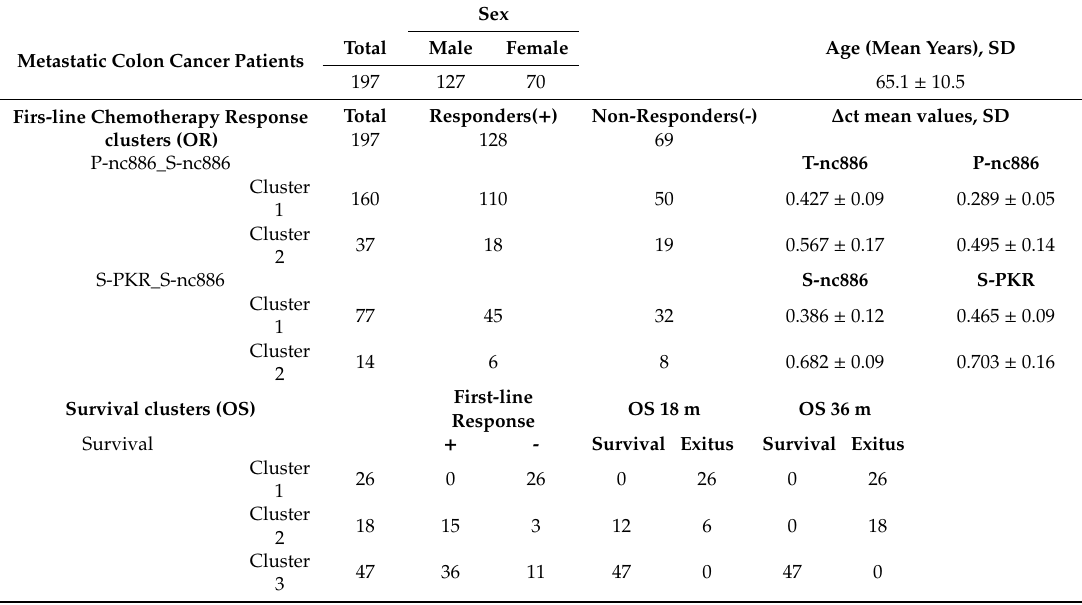
Table 1. Clusters of patients associated with objective first-line chemotherapy response and with overall survival at 18 and 36